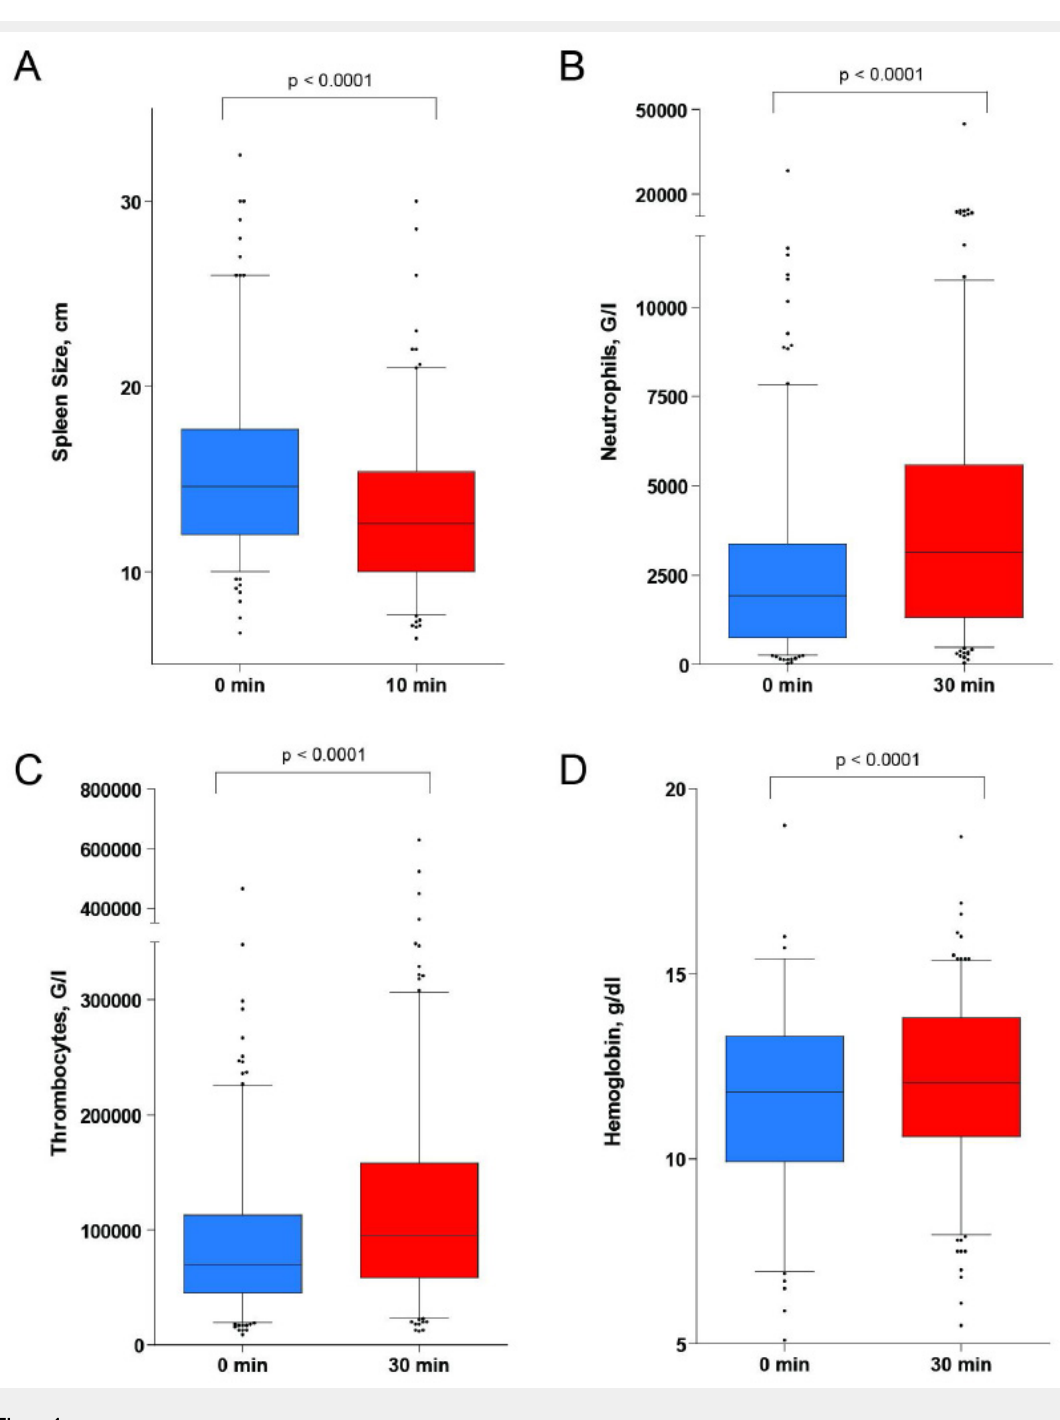
Figure 1 Changes in spleen size and peripheral blood count during epinephrine stimulation test (EST). Peripheral blood count and spleen pole diameter were determined before and at 30 min or 10 min following epinephrine injection respectively. The box plot indicates the median and the 25 th and 75 th percentile of the data respectively. The whiskers represent the 5 th and 95 th percentile; outliers are directly shown. Statistical analysis: Wilcoxon signed rank